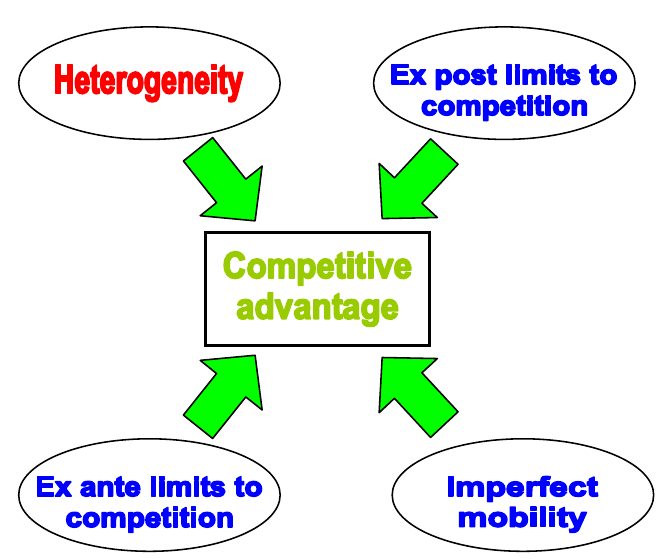
Figure 3. Cornerstones of competitive